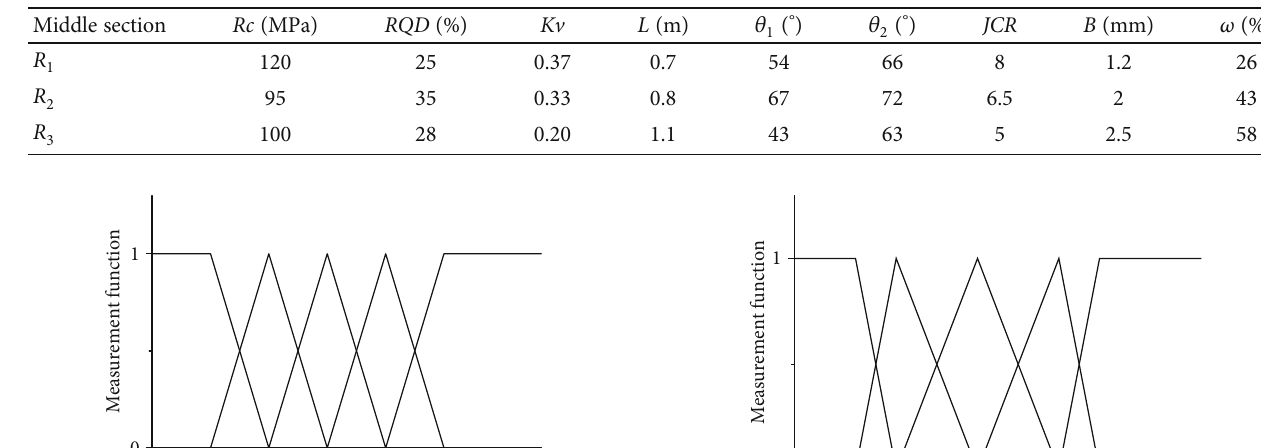
Table 2: The middle section structural surface parameters.